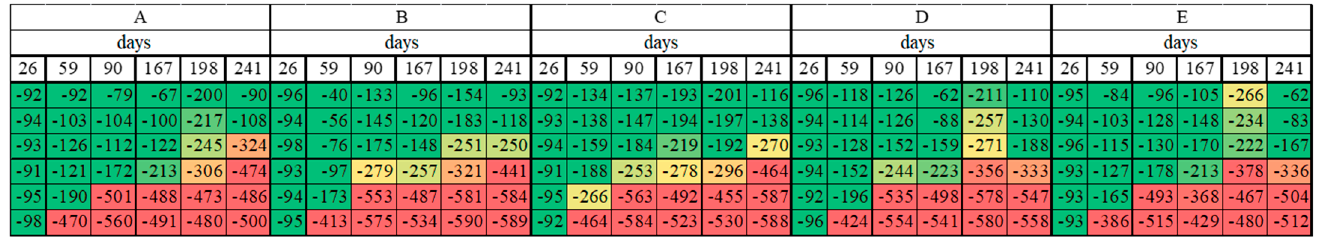
Figure 7. Corrosion potential of bars in mV vs. Cu/CuSO4—rectangular pier.